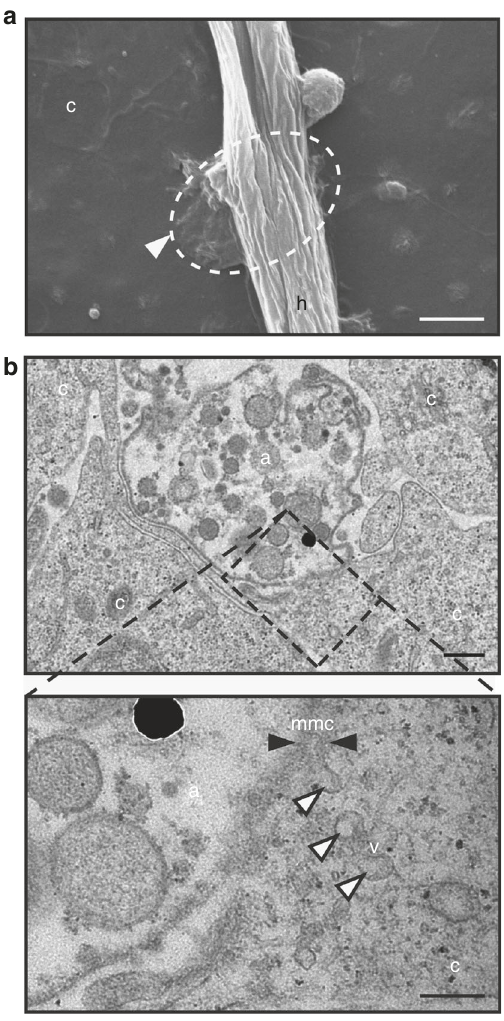
Fig. 1 Infection structure of S. parasitica . a SEM of an hyphae of S. parasitica (h) attached to the surface of a fi sh cell (c). The arrowhead points to an adhesorium-like structure. It is localised underneath the hyphae and fused with the cell membrane. Scale bar: 2 µ m. b TEM of the adhesorium-like structure (a) at the tip of a S. parasitica hyphae with a direct membrane contact (mmc, black arrowheads) with the host cell (c). Magni fi cation of the side of contact (dashed box) reveals expansion and invagination of membranes and numerous vesicles (v, white